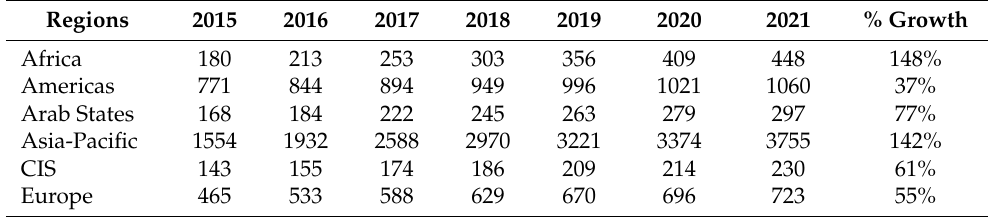
Table 3. Growth in active mobile broadband (3G and above) subscription in millions by region. Regions